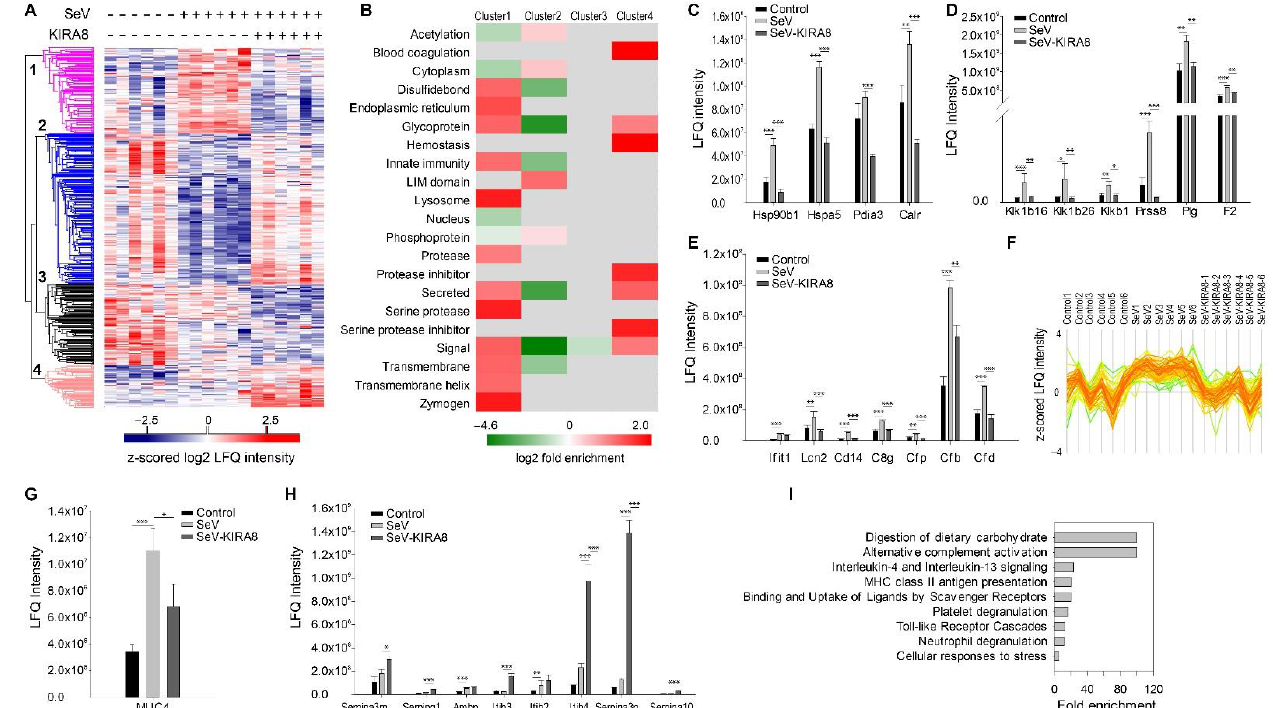
Figure 6. Proteomics analysis of BALF of mice infected with Sandi virus (SeV) in the presence or absence of KIRA8. The mice were infected with SeV in the presence or absence of KIRA8 ( n = 6 in each group). The BALF was analyzed with label-free LC-MS/MS. ( A ) Unsupervised hierarchical cluster analysis of significant proteins (ANOVA with permutation-based FDR < 0.01). The colors of the heatmap represent the z-scored normalized log2 LFQ intensity of each protein. ( B ) GO annotation enrichment analysis of protein in each cluster (FDR < 0.02). The colors of heatmap represent log2 enrichment factors. Red, enrichment; green, depletion; and gray, not significant. ( C ) ER proteins in Cluster 1, whose secretion was induced by SeV and blocked by KIRA8. ( D ) Proteins related to innate immunity. ( E ) Serine proteases and peptidases. ( F ) Profiles of BALF glycoproteins in